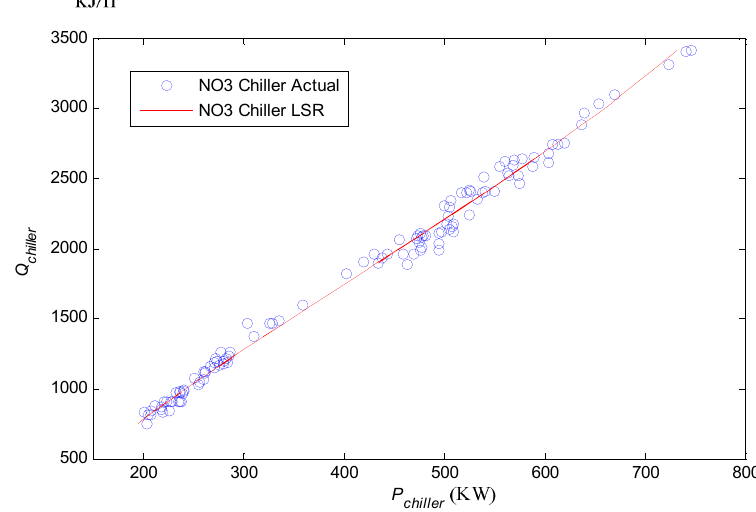
Figure 2. P-Q curve of chiller NO.3.